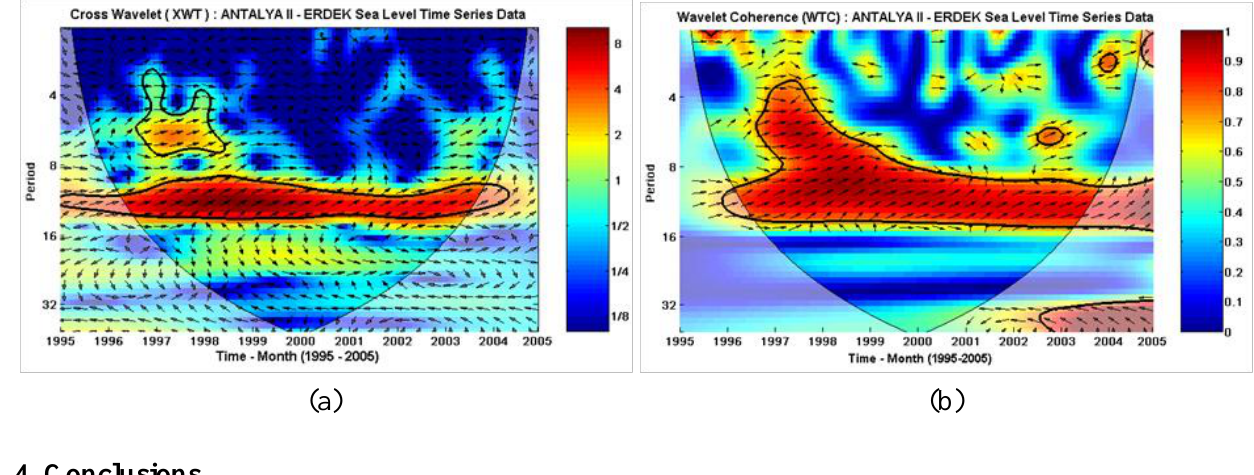
Figure 13. (a) XWT of the monthly sea-level observations at the Antalya-II and Erdek tide gauges. (b) WTC of the monthly sea-level observations recorded at the Erdek and Antalya-II tide gauges. In both plots, the thick black contours indicate the 95% confidence level and the region below the thin line indicates the